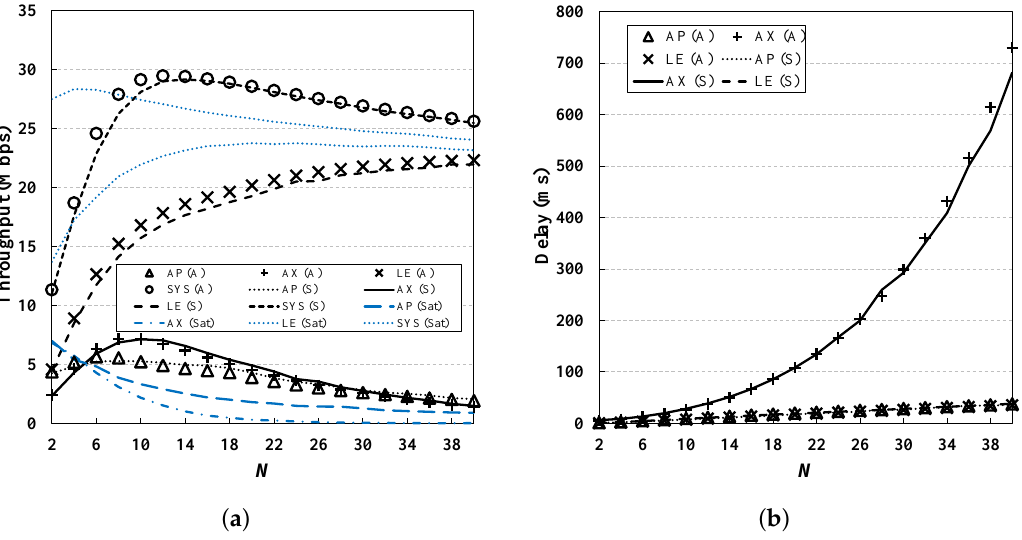
Figure 6. Performance evaluation for different N values. The throughput decreases as N increases, due to the heavy channel contention. For AX STAs, the access delay grows faster than for other STAs, as the TF transmission rate becomes low. ( a ) Throughput; ( b )